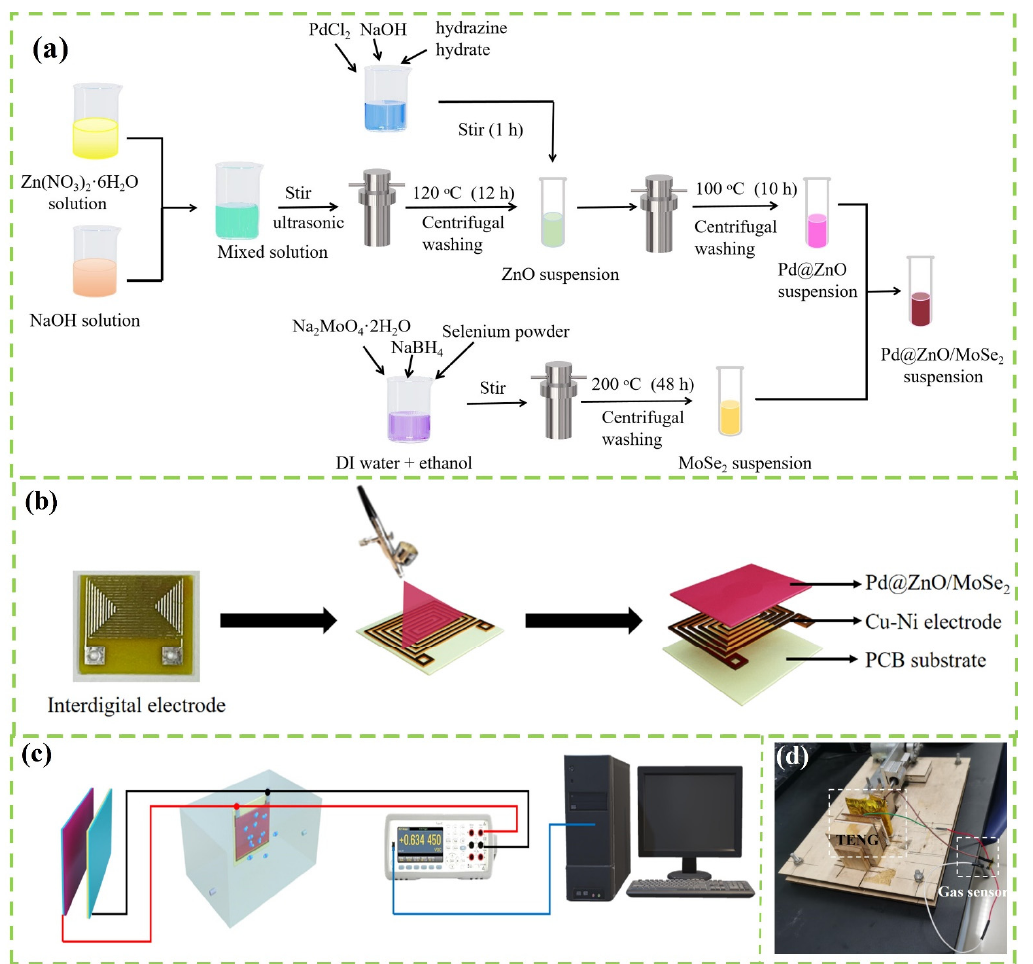
Figure 1. Manufacturing process of ( a ) Pd@ZnO/MoSe 2 and ( b ) gas sensor. ( c ) A diagram of the test system. ( d ) A picture of the TENG and the sensing device powered with TENG.